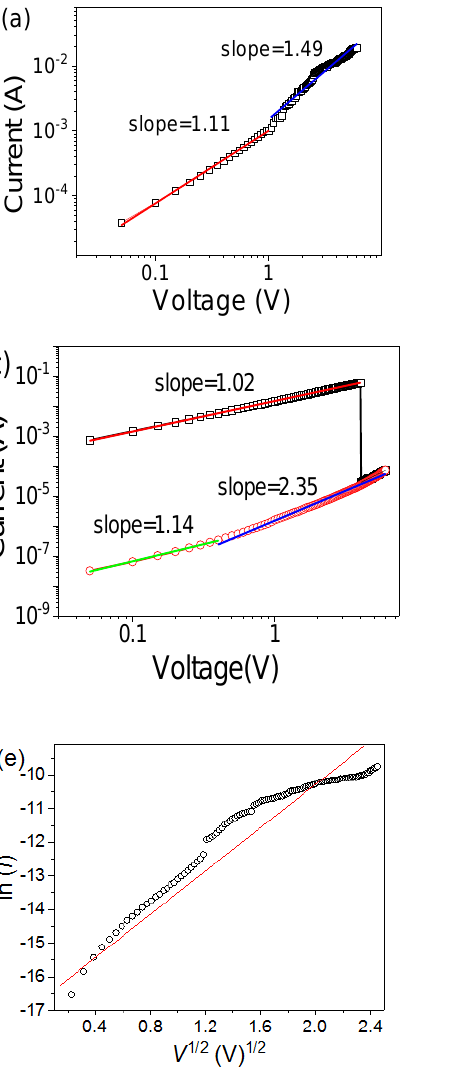
Figure 6. The log( I ) µ log( V ) plots with the Co–Al LDH memristor for space charge-limited conduction fitting for ( a ) HRS and ( b ) LRS. The log( I ) µ log( V ) plots for space charge-limited conduction fitting for the Co–Al LDH-adsorbed hexazinone memristor. ( c ) The negative voltage region. ( d ) The positive voltage region. The ln( I ) µ V 1 / 2 relationship fitting in HRS for ( e ) the Co–Al LDH memristor and ( f ) the Co–Al LDH-adsorbed hexazinone memristor.